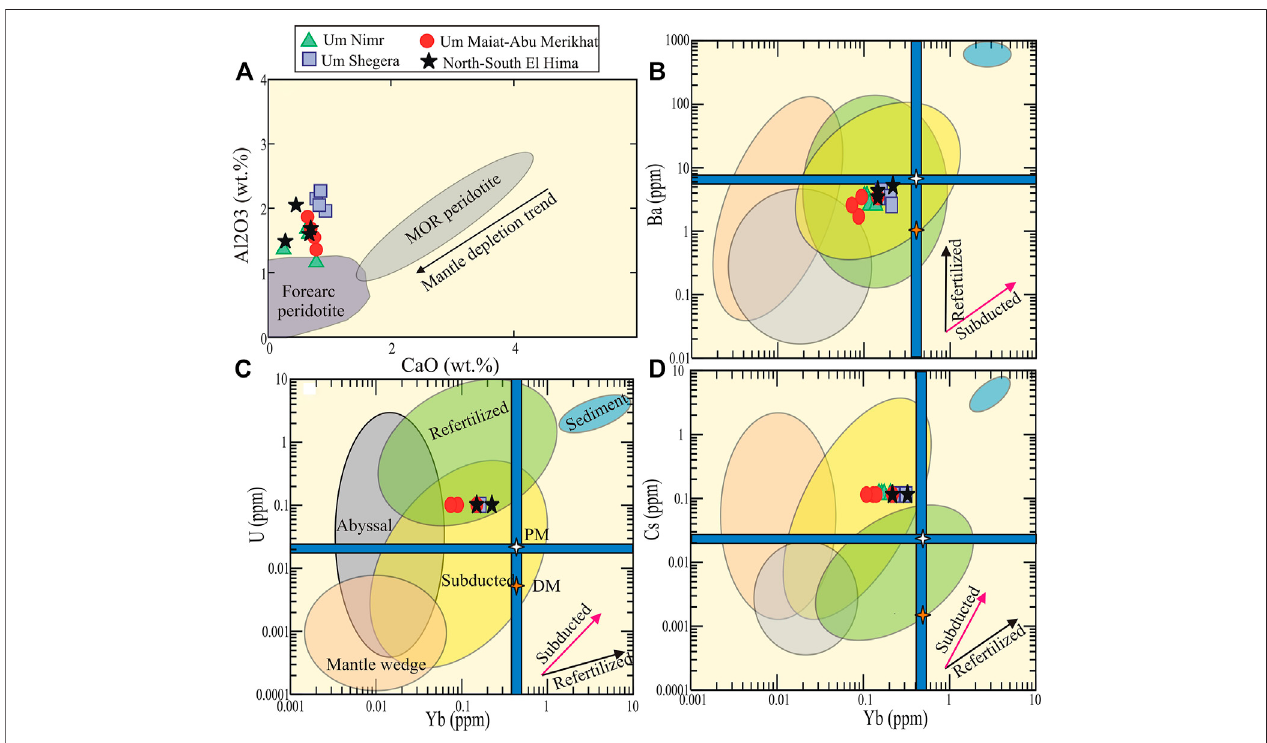
FIGURE 12 | (A) CaO against Al 2 O 3 of bulk rock (Ishii et al., 1992); (B – D) Ba, U, and Cs vs. Yb (ppm) for the examined ultrama fi c rocks (Deschamps et al., 2013). Whiteandredstarsareoftheprimitivemantle(PM)anddepletedmantle (DM)areafterMcDonoughandSun(1995)andSaltersandStracke(2004),respectively.Fieldof sedimentary poles is after Li and Schoonmaker